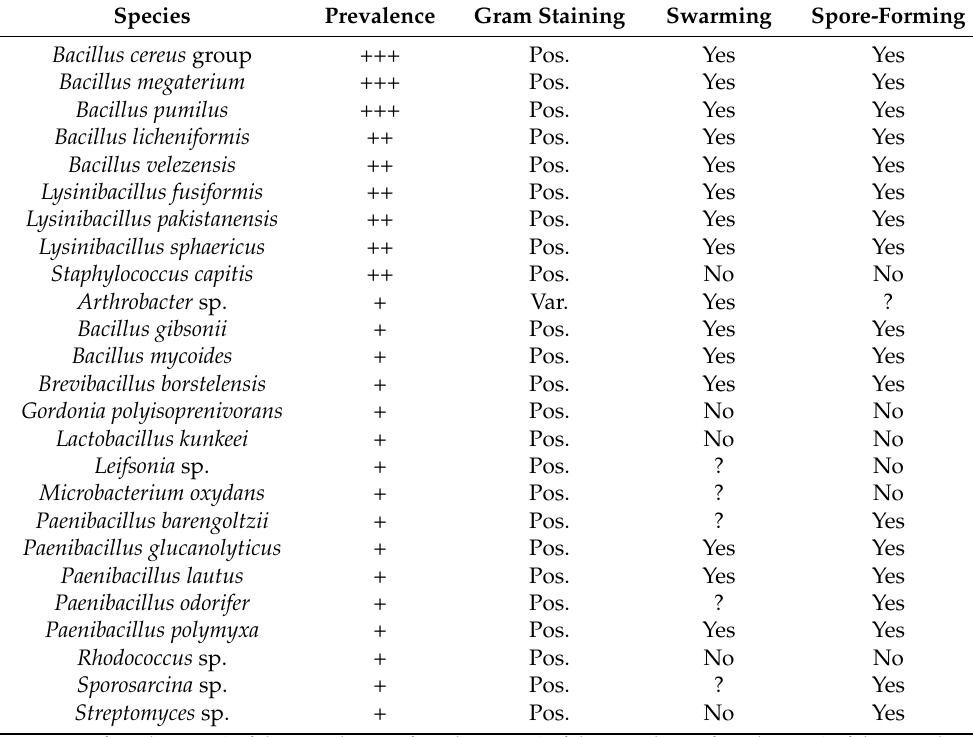
Table 2. Concomitant bacteria identified via 16S rRNA gene sequencing. Species Prevalence Gram Staining